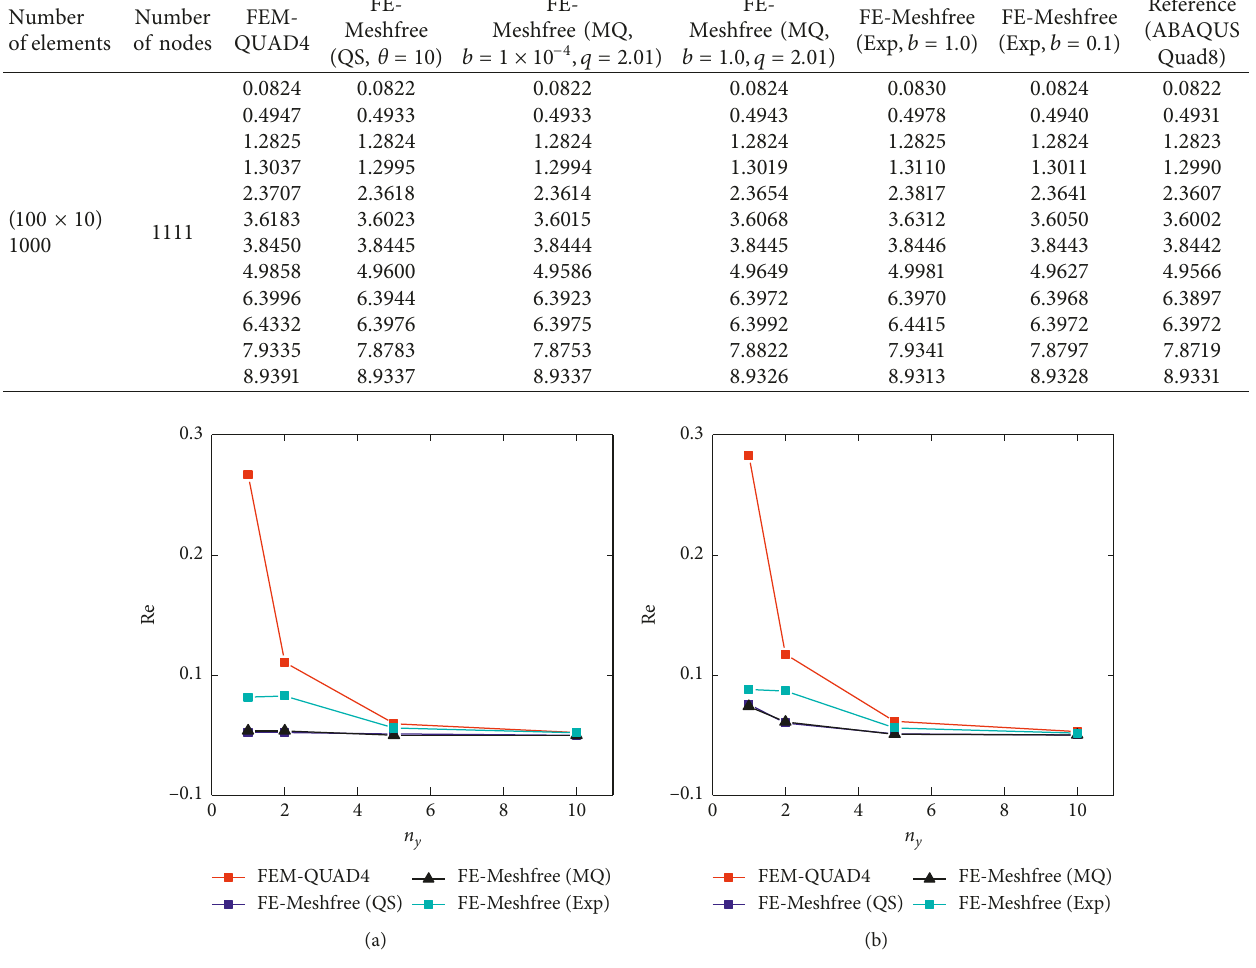
10 4 Hz) of a cantilever beam for 1000 elements. ×